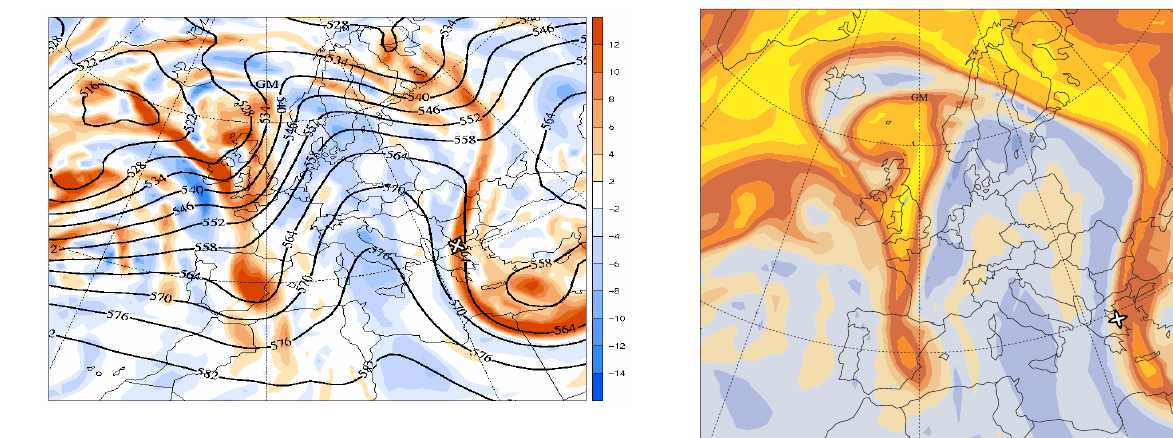
Fig. 2. The ECMWF 500-hPa geopotential height chart (black lines) over Europe on 29 November 2000 at 18:00 UT (Thessaloniki is marked by X). The colour contours correspond to the relative vor- ticity fields (in 10 − 5 s − 1 ) .